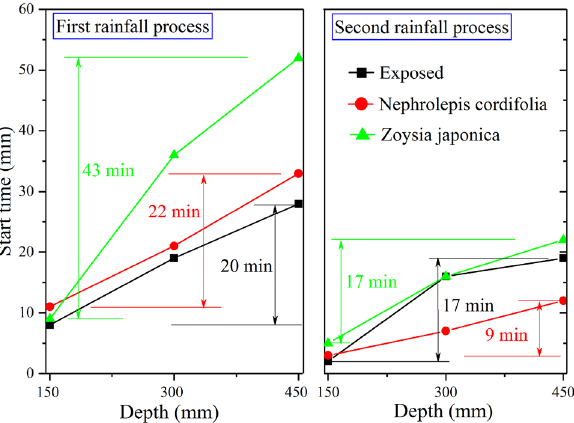
Figure 5. Comparison of the initial time difference of rainwater infiltration at the various